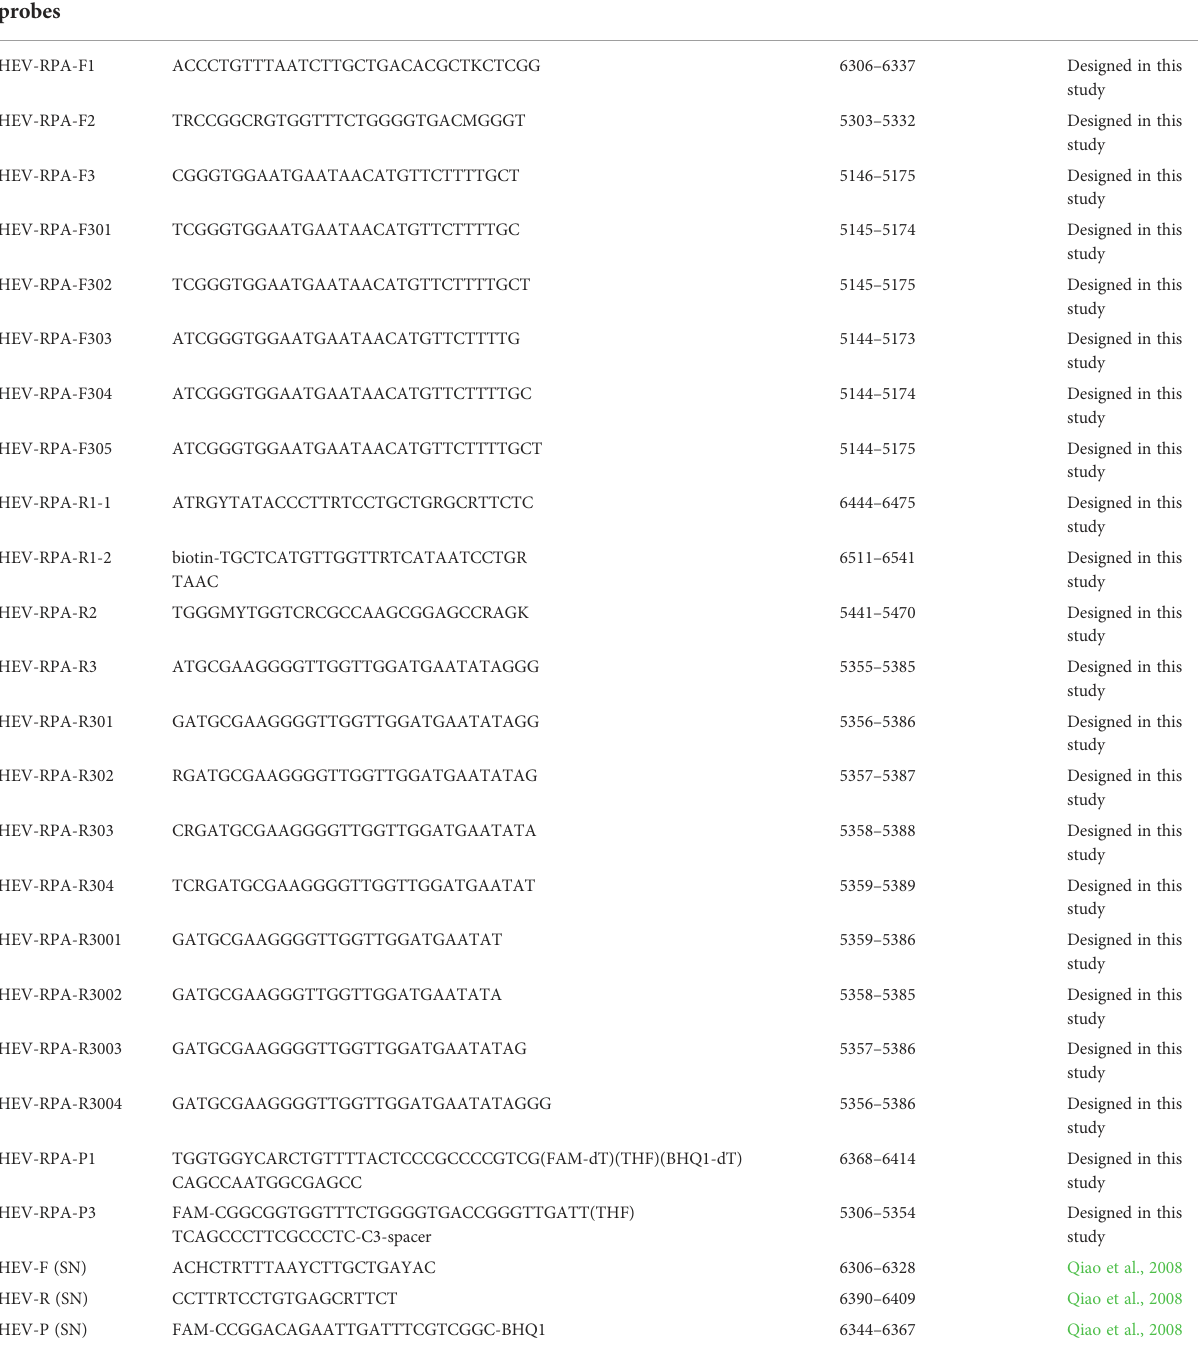
TABLE 1 Sequences of the primers and probes for the HEV qRT-RPA, LFB RT-RPA, and qRT-PCR assays. Primers